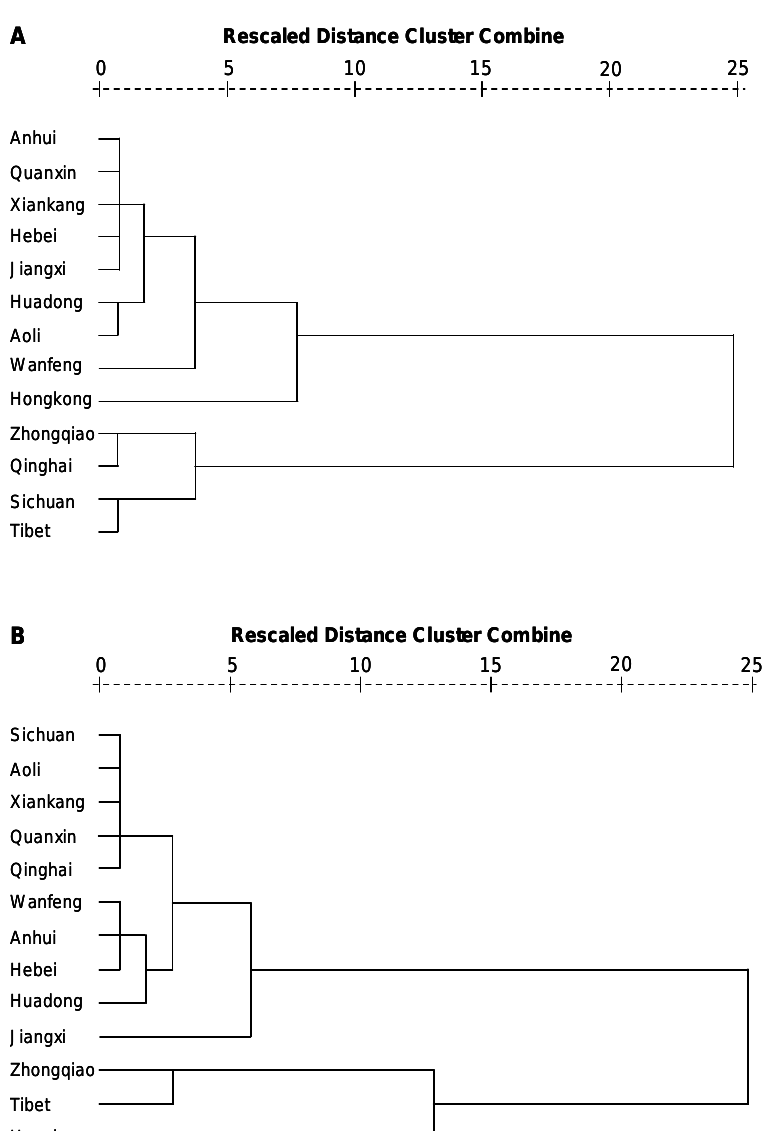
Figure 5. Dendrograms of hierarchical cluster analysis resulting from the content of free (A) and conjunct (B) carbohydrates in 13 samples of Cordyceps